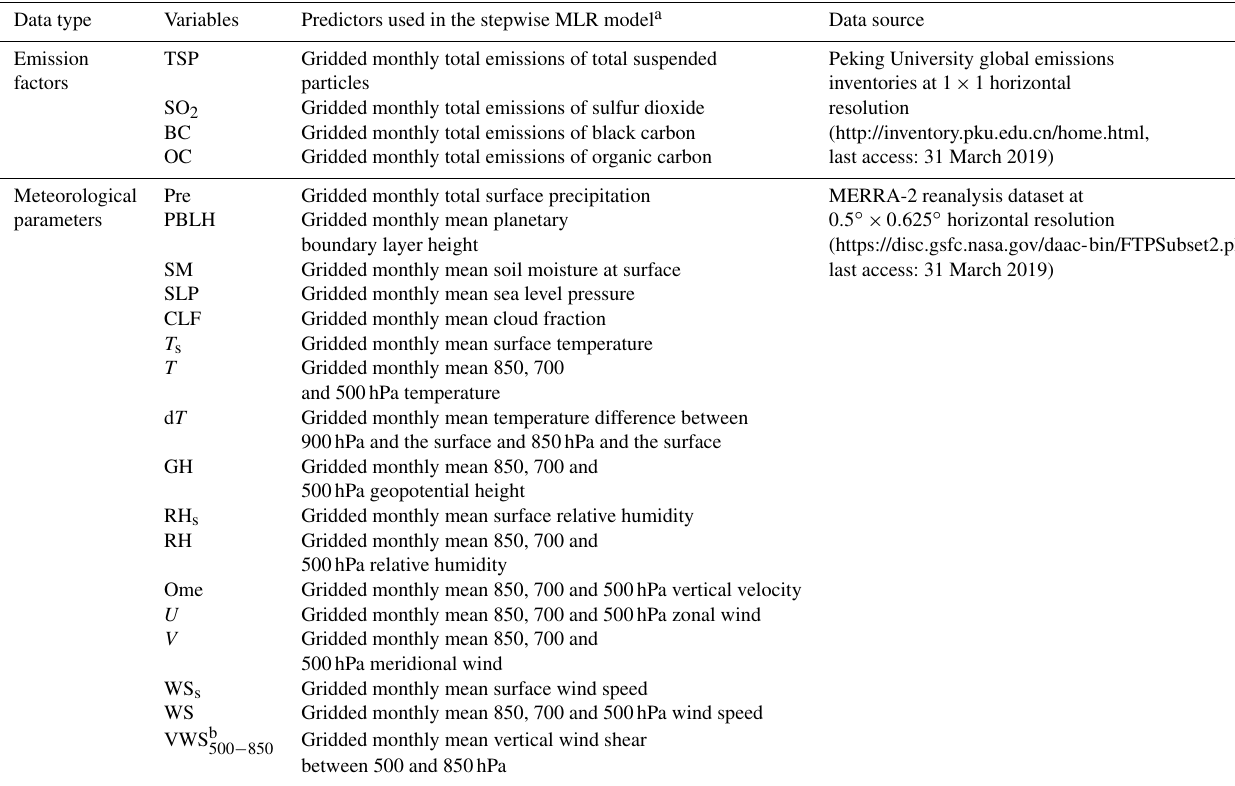
q calculated as (U 500 − U 850 ) 2 + (V 500 − V 850 ) 2